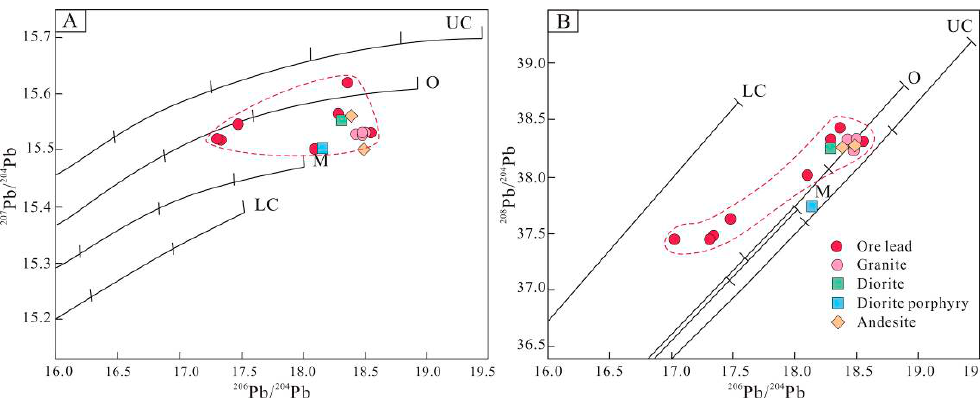
Figure 12. Lead isotopic compositions for sulfides and host rocks in the Jinchang deposit. ( A ) 207 Pb/ 204 Pb versus 206 Pb/ 204 Pb plot; ( B ) 208 Pb/ 204 Pb versus 206 Pb/ 204 Pb plot. Abbreviations: UC, upper crust; O, orogen; M, mantle; LC, lower crust. The average growth curve is from Zartman and Doe [67]. Lead isotope data are from Mu et al. [14].